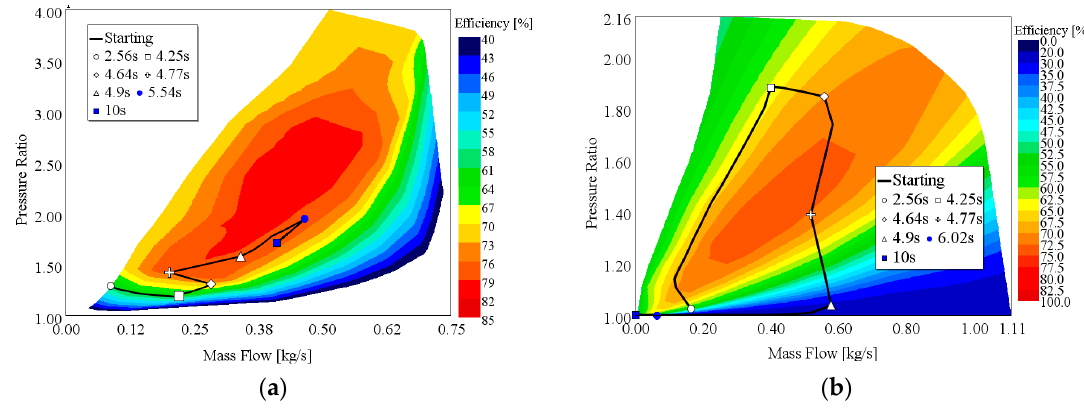
Figure 15. Vehicle starting process simulation results: ( a ) Compressor; ( b ) Supercharger.